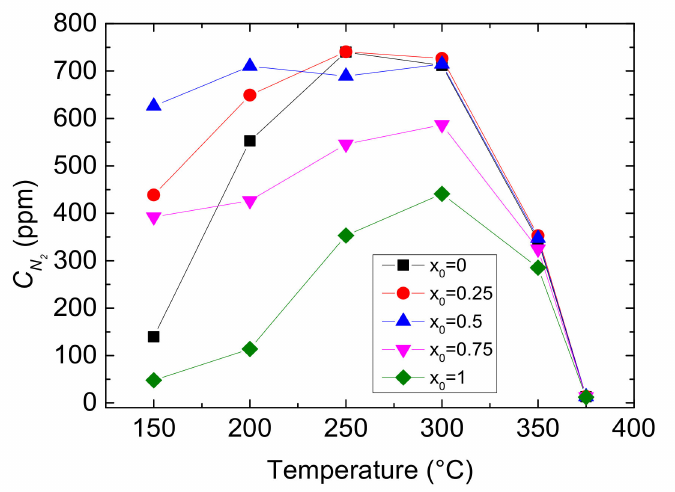
Figure 5. Outlet C N2 with different values of x 0 and reaction